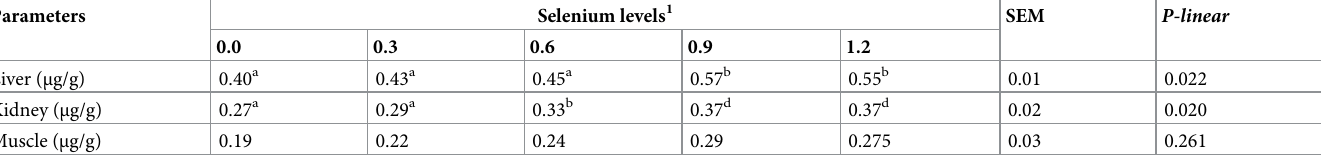
Table 4. Bioaccumulation of selenium in different organs of juvenile silver carp fed on different levels of selenium methionine. Parameters Selenium levels 1 SEM